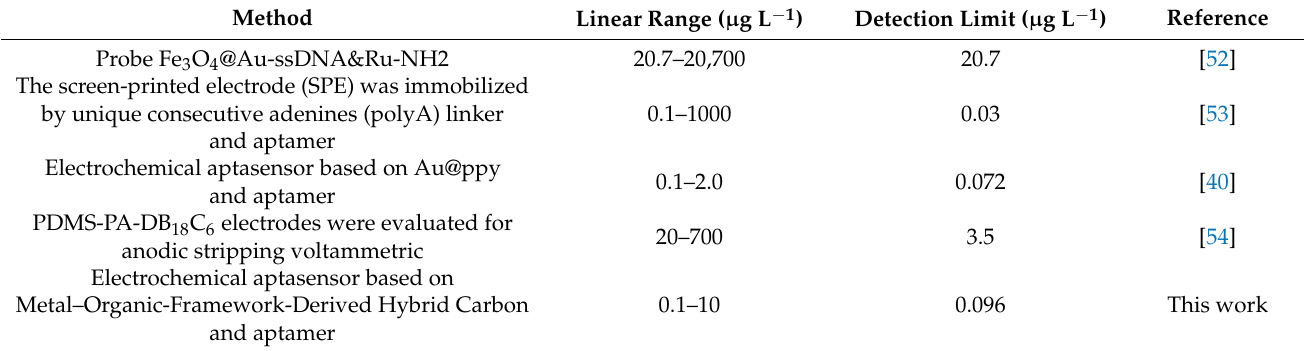
Table 1. Comparison of different sensors for determination of Pb 2+